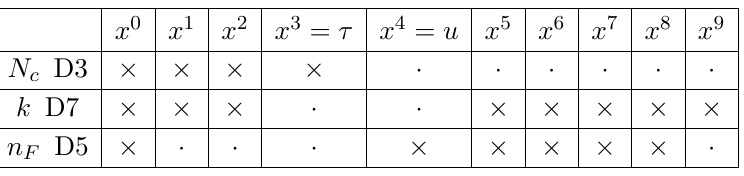
Table 2 . D brane setup of the top-down construction of a SU( N c ) k Fermi-Hubbard model. (cid:28) is the compacti(cid:12)ed cigar direction, u is the holographic direction, and x 5 ::: 9 are the S 5 coordinates. We choose an embedding of S 4 into S 5 such that x 5 ::: 8 parametrizes the S 4 wrapped by the D5